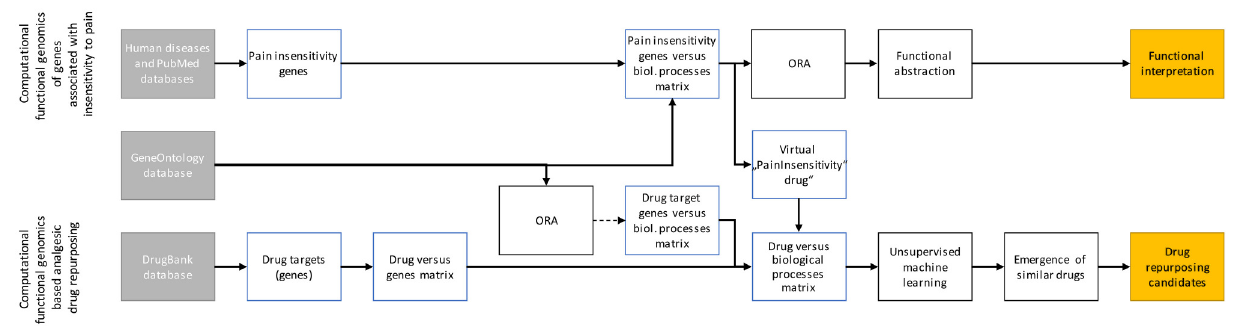
FIGURE 1 | Scheme of the data analysis workflow. The analyses had two major aims, i.e., (i) assessing the biological functions of genes reportedly associated with insensitivity to pain (upper line) and (ii) using the biological processes in which these genes are involved to find repurposing candidates among DrugBank listed drugs (lower line). To this end, genes were identified in databases and their biological functions were associated based on the annotations in the Gene Ontology database; for the drug target coding genes ( > 4,000) with a filter for too many irrelevant terms implemented as an overrepresentation analysis. Such filter was not necessary for the only 20 genes associated with insensitivity to pain. However, for the latter, overrepresentation analysis (ORA) followed by functional abstraction was performed to obtain a comprehensible set of > 10 biological functions which summarize the biological roles of these genes in an interpretable manner. The information obtained in the ORA of the 20 pain insensitivity genes was used to generate a virtual “pain drug” that was introduced into the “drug vs. biological processes” matrix of all drugs. Subsequently, unsupervised machine learning was used to find data structures among all drugs. Those drugs that, in the high dimensional vector space of associations with GO terms (biological processes), laid near the virtual “PainInsensitivity drug” were the repurposing candidates.